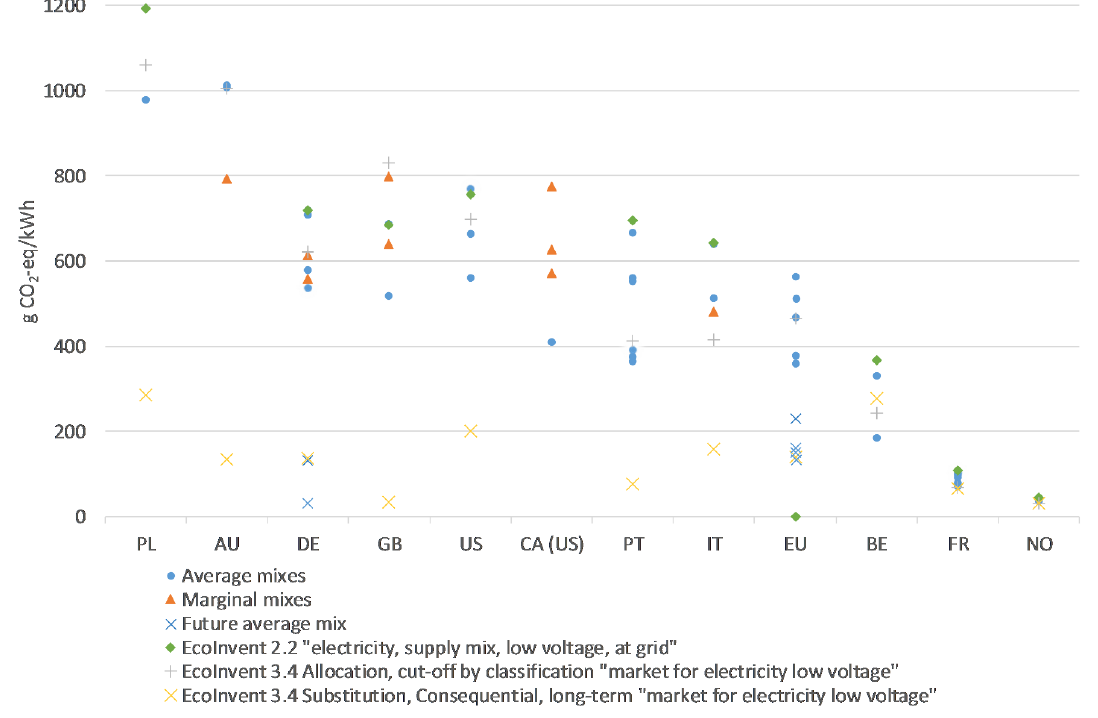
Figure 11. Spread of the carbon intensity of electricity mixes used in the articles reviewed and in the main database.